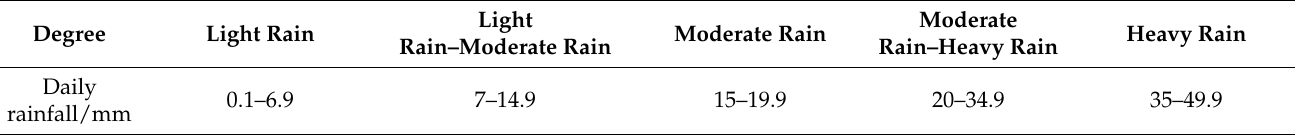
Table 2. Rainfall classification table.